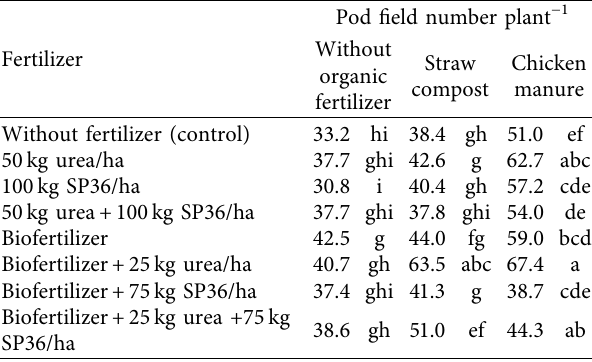
Table 5: Effect of organic fertilizer from the rainy season and inorganic and biofertilizer applied in the second dry season on pod field number plant − 1 of soybean.